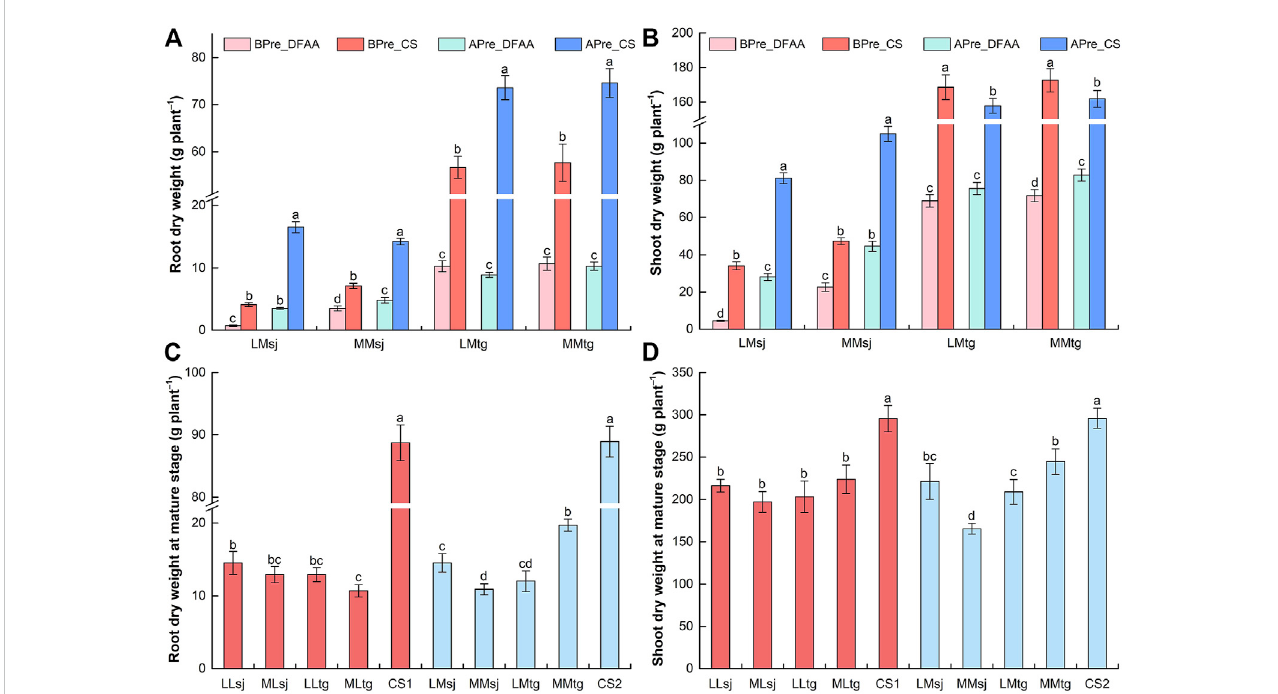
FIGURE 1 Changes of root dry weight, and shoot dry weight in different treatments. (A,C) changes of root dry weight during DFAA process, at the mature stage. (B,D) changes of shoot dry weight during drought- fl ood abrupt alternation (DFAA) process, at the mature stage. Error bars represent standard deviations ( n = 3), different letters in the same row indicated signi fi cant difference among the treatments at 0.05. Note: LLsj, light drought-light fl ood in the seeding-jointing stage (SJS); MLsj, moderate drought-light fl ood in the SJS; LLtg, light drought-light fl ood in the tasseling-grain fi lling stage (TGS); MLtg, moderate drought-light fl ood in the TGS; LMsj, light drought-moderate fl ood in the SJS; MMsj, moderate drought-moderate fl ood in the SJS; LMtg, light drought- moderate fl ood in the TGS; MMtg, moderate drought-moderate fl ood in the TGS; CS1 and CS2, control system operated under natural climatic conditions; BPre_DFAA, after drought period of DFAA; APre_DFAA, after fl ooding period of DFAA; BPre_CS, APre_CS, changes in CS treatment at the same time point of BPre_DFAA,